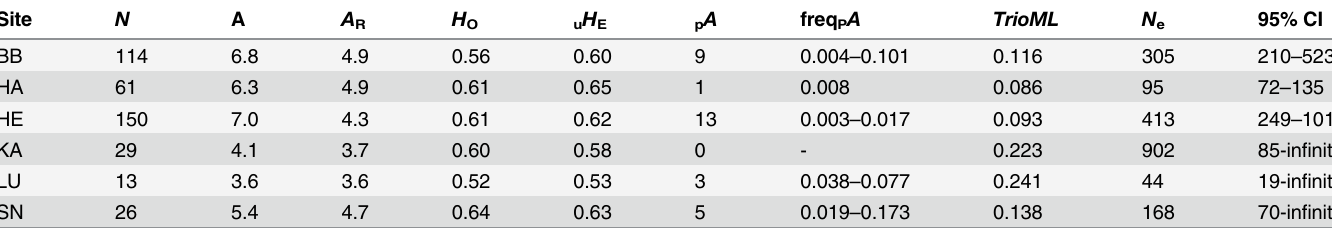
Table 2. Comparison of genetic variability among STRUCTURE-defined genetic